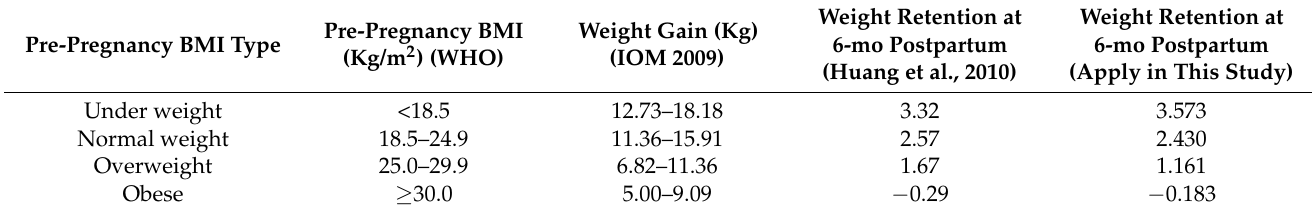
Table 6. Comparison of weight retention at six-month postpartum for different types of